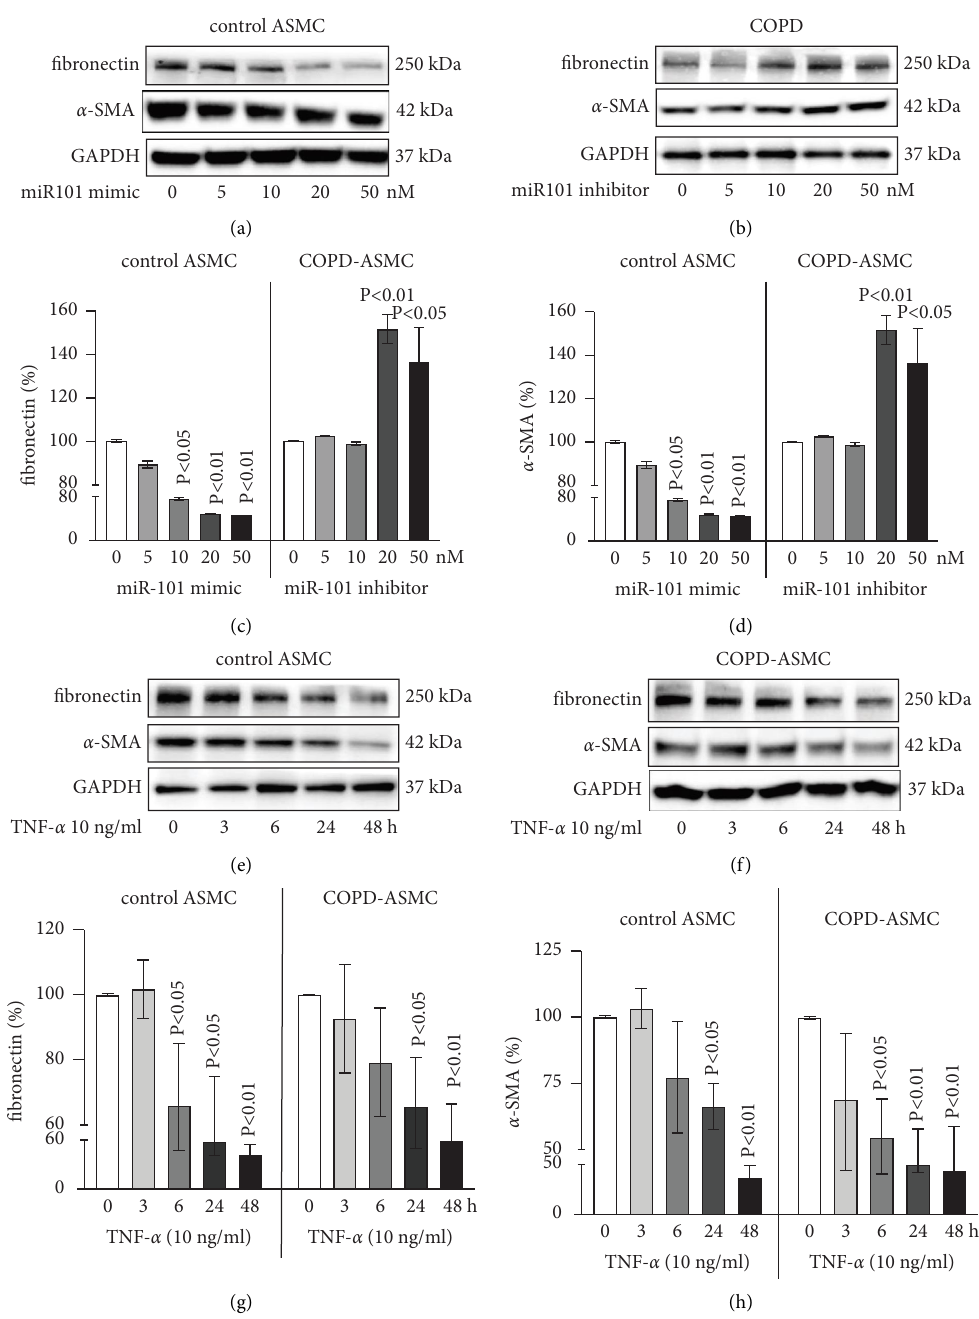
Figure 4: Te efect of miR-101-3p and TNF- α on ASMC remodeling. (a) Western blots for fbronectin and α -SMA protein expression in ASMC of healthy nonsmokers ( n � 3) treated with miR-101-3p mimics at 48 hours. (b) Western blots for fbronectin and α -SMA protein expression at 48 hours in COPD-ASMC ( n � 3) treated with miR-101-3p mimics. (c) Image analysis of fbronectin expression in ASMC of healthy nonsmokers (control) and COPD, as shown in Figures 4(a) and 4(b). (d) Image analysis of α -SMA expression in ASMC of healthy nonsmokers (control) and COPD, as shown in Figures 4(a) and 4(b). (e) Western blots of TNF- α -induced fbronectin and α -SMA protein expression in ASMC of healthy nonsmokers (control). (f) Western blots of TNF- α -induced fbronectin and α -SMA protein expression in COPD-ASMC. (g) Image analysis of TNF- α -induced fbronectin expression in ASMC of healthy nonsmokers (control) and COPD, as shown in Figures 4(e) and 4(f). (h) Image analysis of TNF- α -induced α -SMA expression in ASMC of healthy nonsmokers (control) and COPD, as shown in Figures 4(e) and 4(f). Bar charts represent protein expression as mean ± S.E.M. All P values represent comparison to untreated